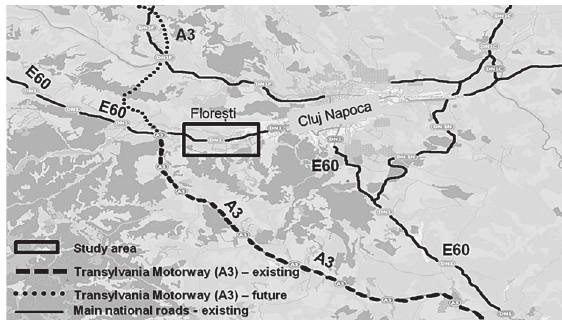
Fig. 3. Study area location Fig. 4. Florești layout along E60 road (newly built areas are encompassed)